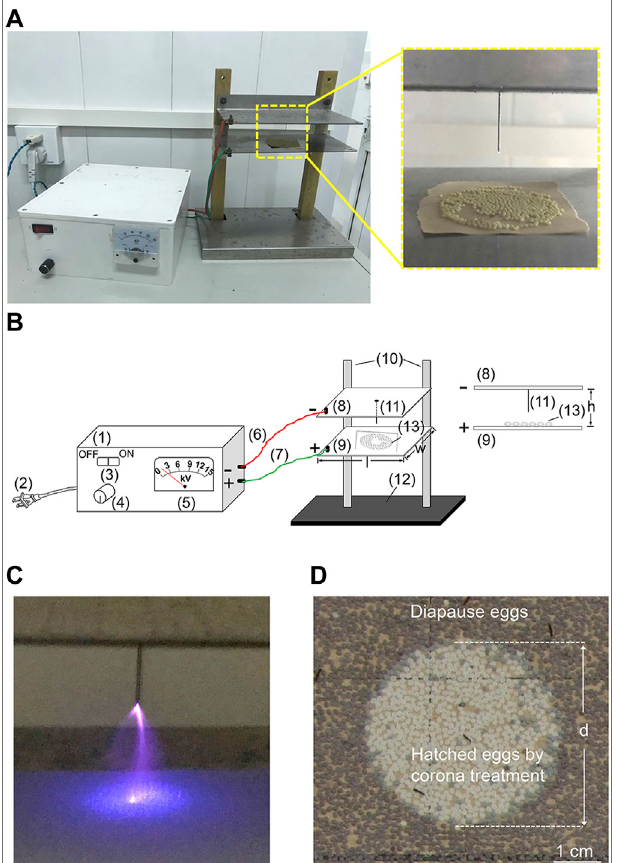
FIGURE 1 | Composition of the self-made GZ-01 arti fi cial corona instrument and the range of action of the corona treatment on silkworm eggs. (A) Photographs of eggs processed by the GZ-01 corona instrument. (B) Illustration of the GZ-01 corona incubator: 1) metal shell of the high voltage direct current power supply; 2) power plug (connected to a 220 V household alternating current source); 3) power switch; 4) voltage adjusting knob;5)voltagedisplay(0 – 15 kV);6)negativeconnectionline(red); 7)positive connection line (green); 8) negative and 9) positive electrode metal plates (l = 15 cm, w = 8 cm, h = 18 mm); 10) insulation supports; 11) metal pole needle (length = 10 mm, pole pitch = 8 mm); 12) base; 13) Kraft paper covered with eggs. (C) Photographofthecoronadischargeinweaklight. (D) Photographof the effect of corona treatment in preventing the diapause of newly laid DZ